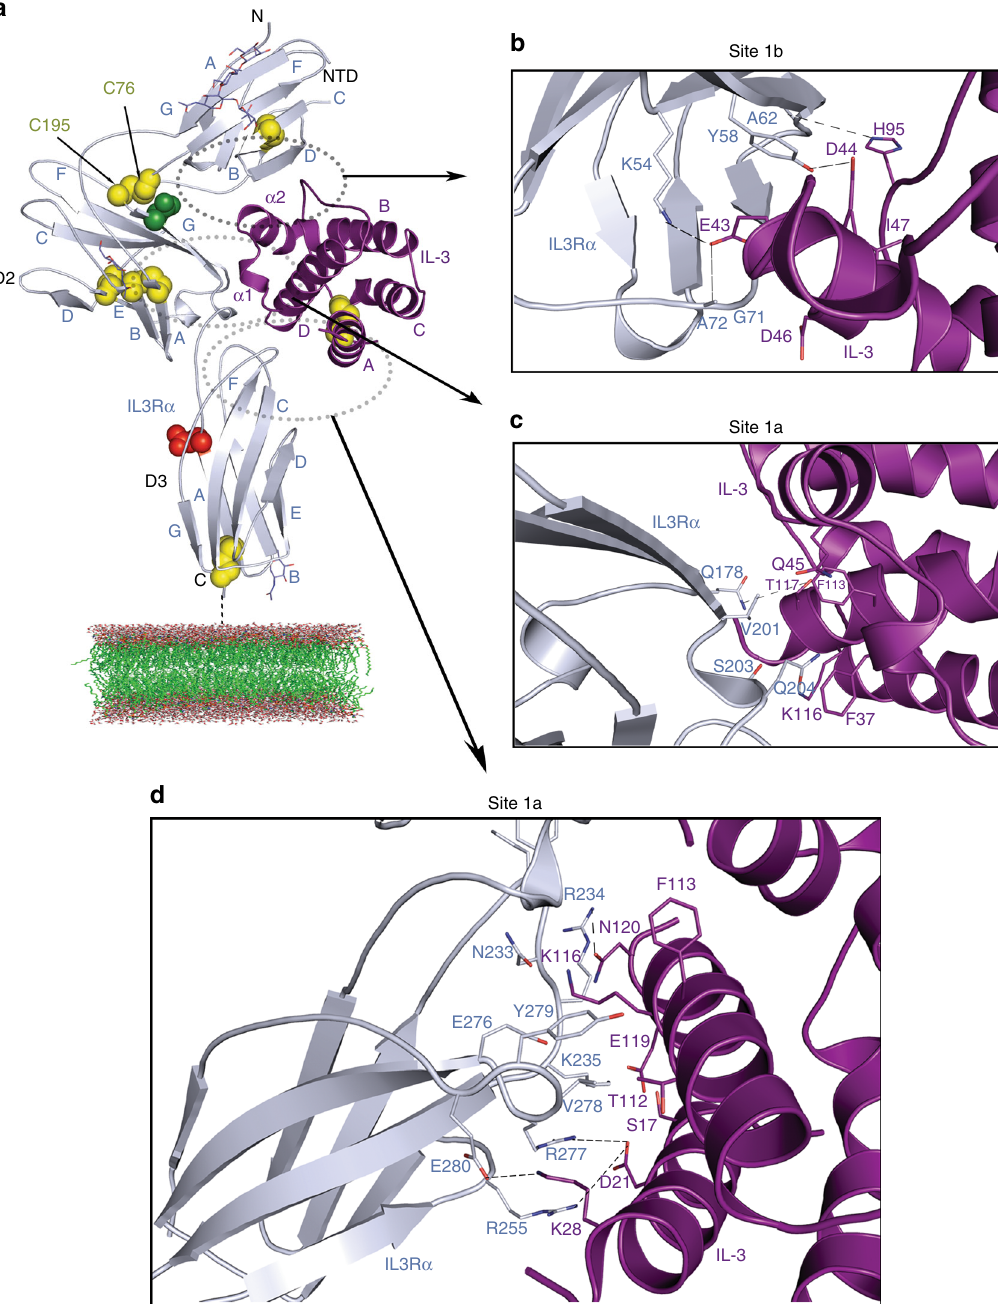
Fig. 1 Crystal structure of the IL-3 binary complex. a The structure of IL3R α (coloured blue-grey in all panels) bound to the four α -helical bundle of IL-3 (coloured purple in all panels). The β -strands that make up the three FnIII domains (NTD, D2 and D3) and the N- and C-termini are labelled. The cysteine residues in IL3R α are represented as yellow spheres and the bound sugars at N80, N109 and N218 of ILR α are shown as sticks. The mutated N212Q residue is shown as red spheres. D197 is represented as green spheres. b A close-up view highlighting key interactions between IL-3 and the IL3R α NTD (site 1b). Hydrogen bonds are shown as black dashed lines in all panels. c A close-up view highlighting key interactions between IL-3 and the IL3R α D2 – D3 linker region (part of site 1a). d A close-up view highlighting key interactions between IL-3 and the IL3R α D3 (part of site 1a). Together, c and d de fi ne the complete site